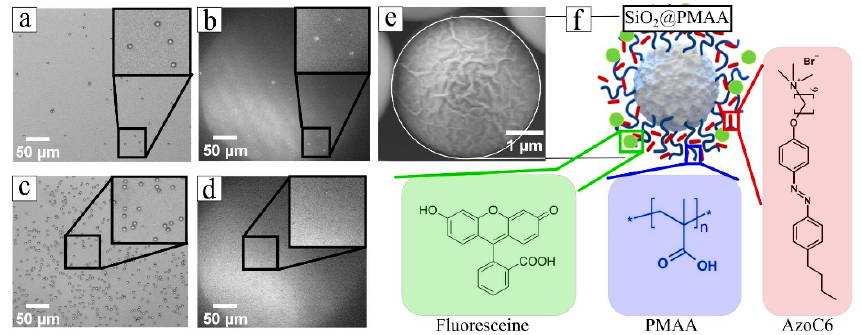
Figure 1. ( a – d ) Optical micrographs in transmission ( a , c ) and emission mode for silica colloids loaded with fluorescein and photosensitive surfactant: ( a , b ) SiO 2 @PMAA and ( c , d ) SiO 2 . ( e ) SEM micrographs of SiO 2 @PMAA coated with polymer layer. ( f ) Scheme of the PMAA (blue lines) spherical brush loaded with surfactant (red rods) and fluorescein (green spheres) and corresponding chemical structures of cationic azobenzene containing surfactant (C 4 -azo-OC 6 -TMAB, red), poly(methacrylic acid) chain (blue), and fluorescein (green).